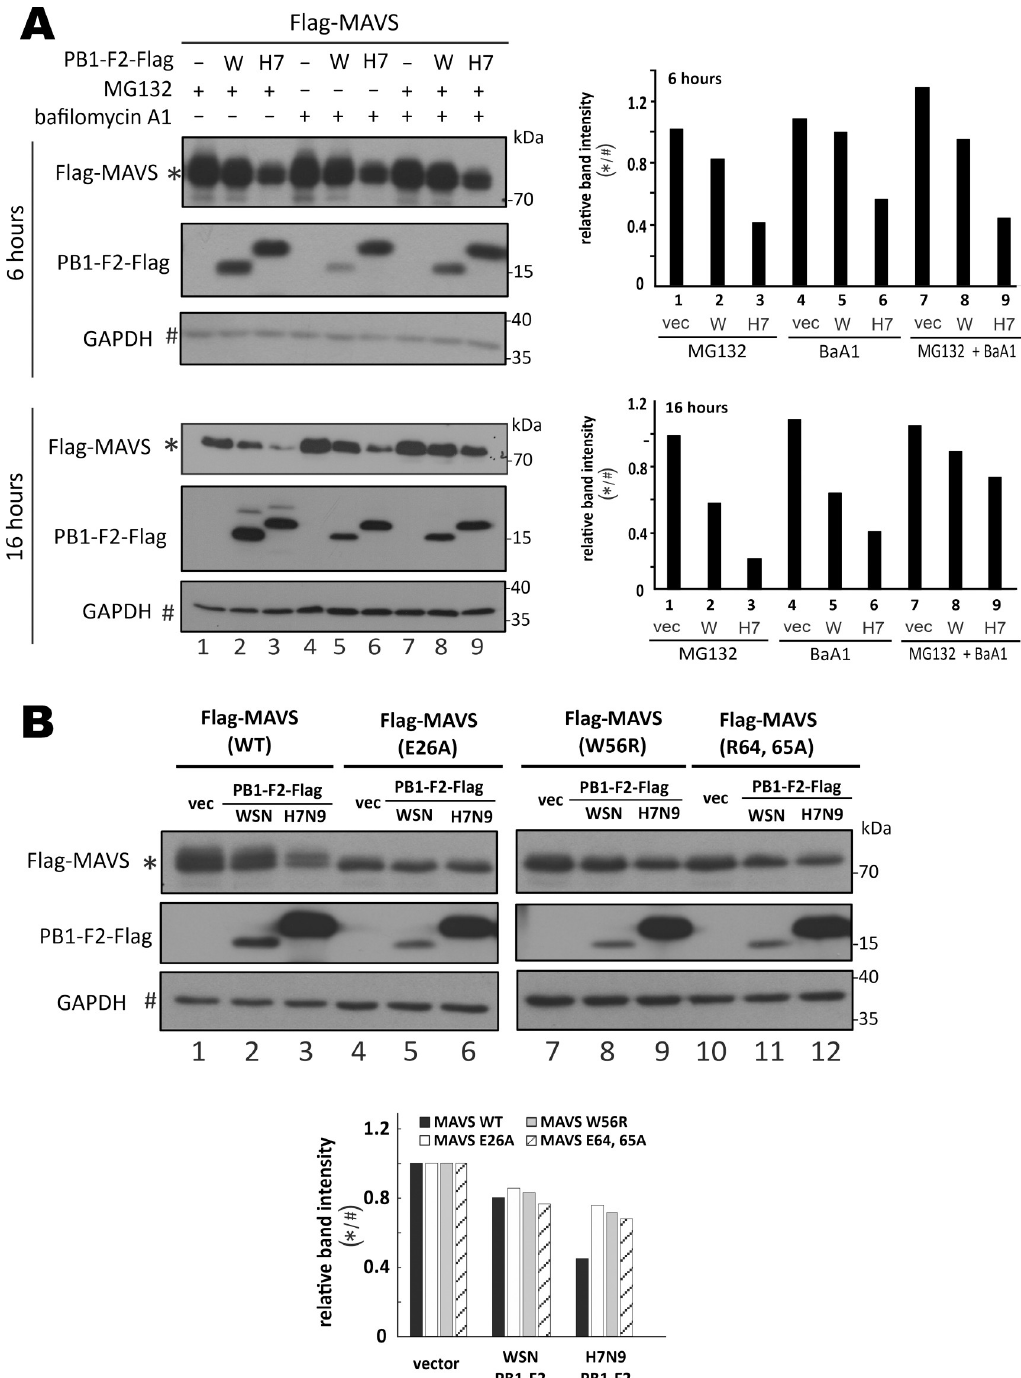
Fig 6. H7N9 PB1-F2-induced destabilization of MAVS protein aggregate for proteasomal and lysosomal degradation. ( A ) Treatment with proteasome and lysosome inhibitors. HEK293T cells in 6-well plates were co-transfected with 1 μ g PB1-F2-Flag expression construct and 1 μ g pEF-Bos-Flag-MAVS. After 24 hours, 20 μ M MG132, 100 nM bafilomycin A1 (BaA1) or their combination was added for 6 or 16 hours before cells were harvested for total protein extraction and SDS-PAGE Western blot analysis against anti-Flag. Relative band intensity of MAVS over GAPDH was plotted in the right panel. ( B ) Analysis of aggregation-defective mutants of MAVS. HEK293T cells were co-transfected with 0.5 μ g PB1-F2 expression construct and 0.5 μ g pEF-Bos-Flag-MAVS WT, E26A, W56R or R64, 65A. After 48 hours, total protein was extracted from the cells and subjected to SDS-PAGE followed by Western blot analysis with anti-Flag for detection of MAVS at 70 kDa and PB1-F2 at 15-20kDa. Relative